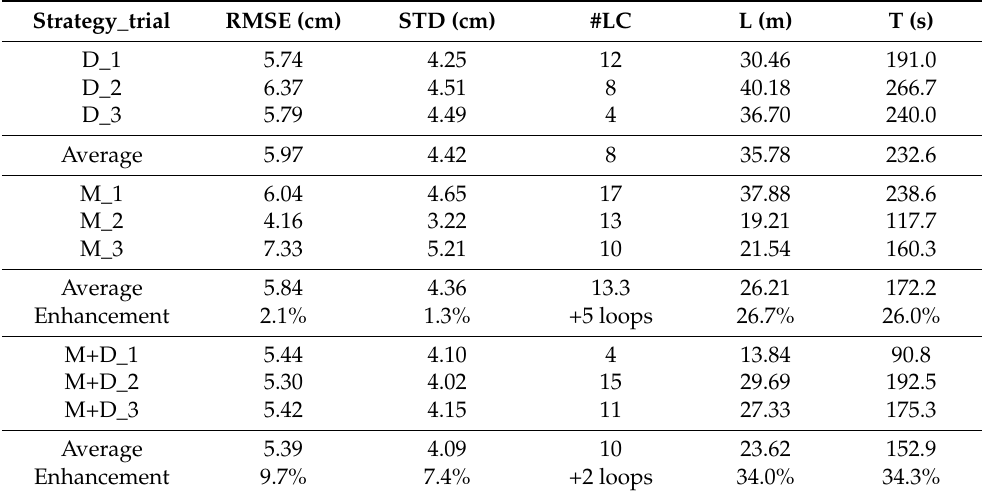
Table 3. Texture-rich results. PTPD RMSE (cm), PTPD STD (cm), number of loop closures (LCs), exploration path length (L) (m), and exploration time (T)